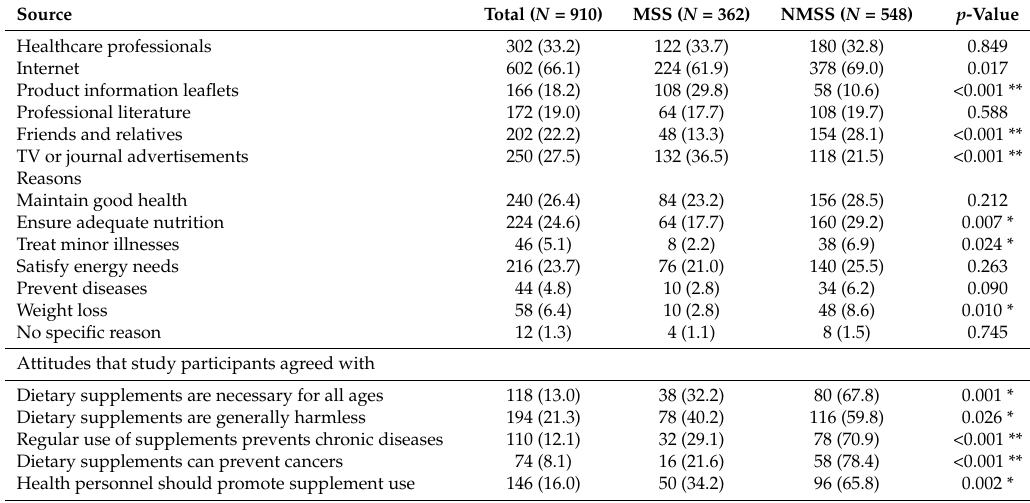
Table 3. Source of dietary supplements information and reasons for taking dietary supplements among the study participants from medical and nonmedical sciences faculties ( N = 910) ( N (%)).